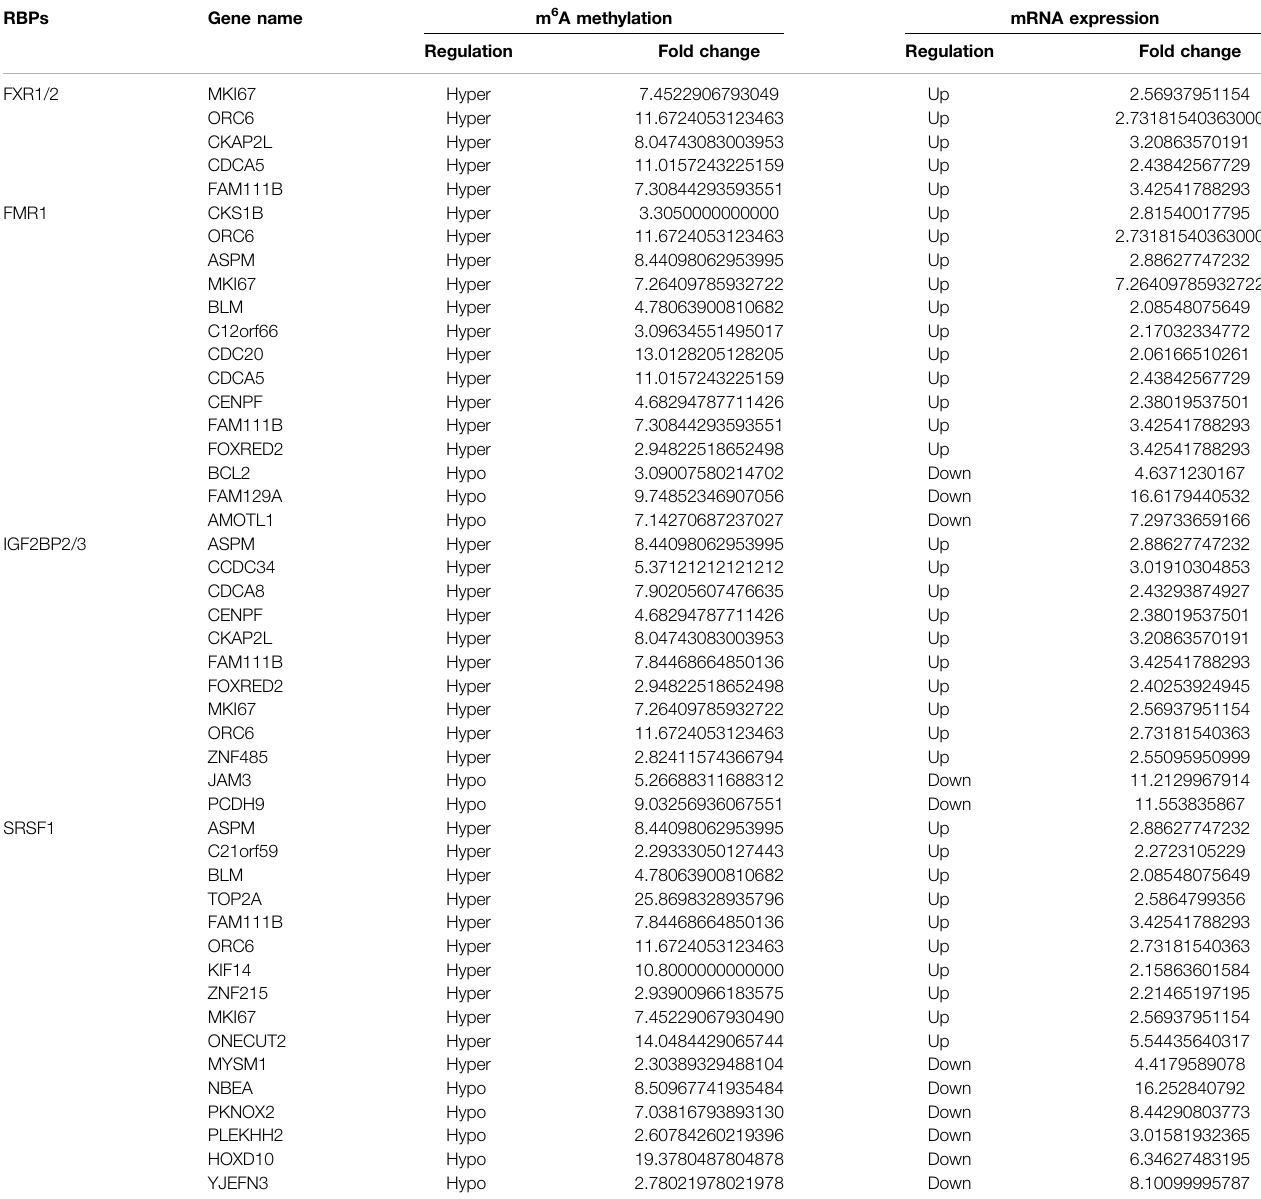
TABLE 5 | The corresponding mRNA of FXR1/2, FMR1, IGF2BP2/3, and SRSF1.